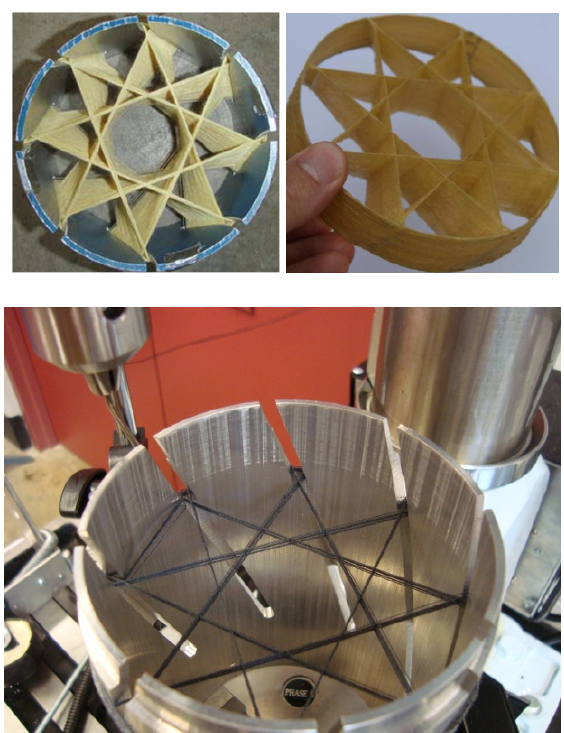
Figure 1. PrototypesofKevlarfiber/epoxymatrixcompositematerial wheel(upper)CNCwindingandschematicofwindinglayer